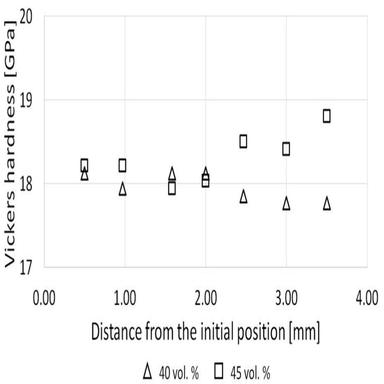
Hardness distribution at the cross-section of the produced composites with different solid phase content.